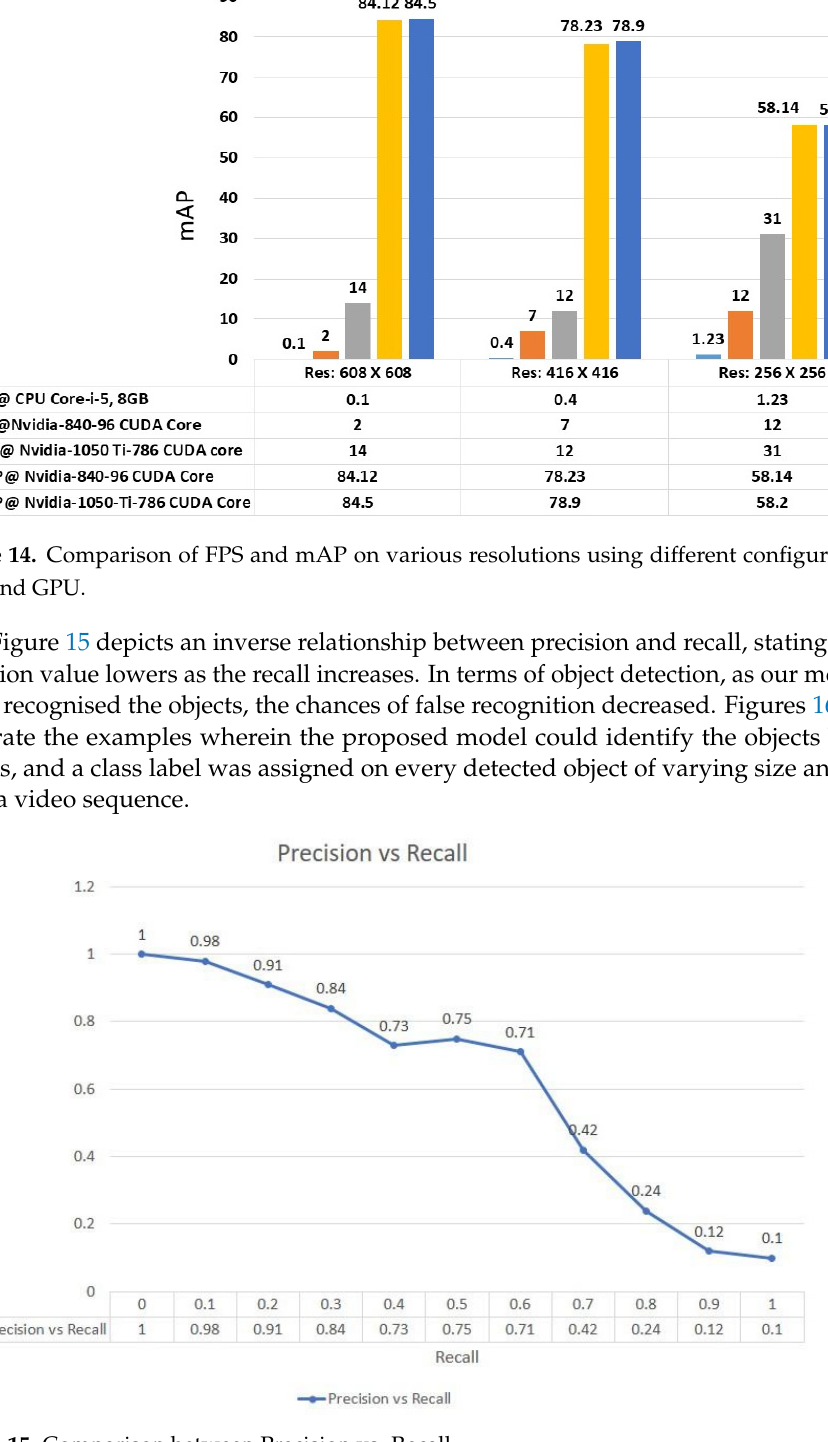
Figure 15. Comparison between Precision vs. Recall.